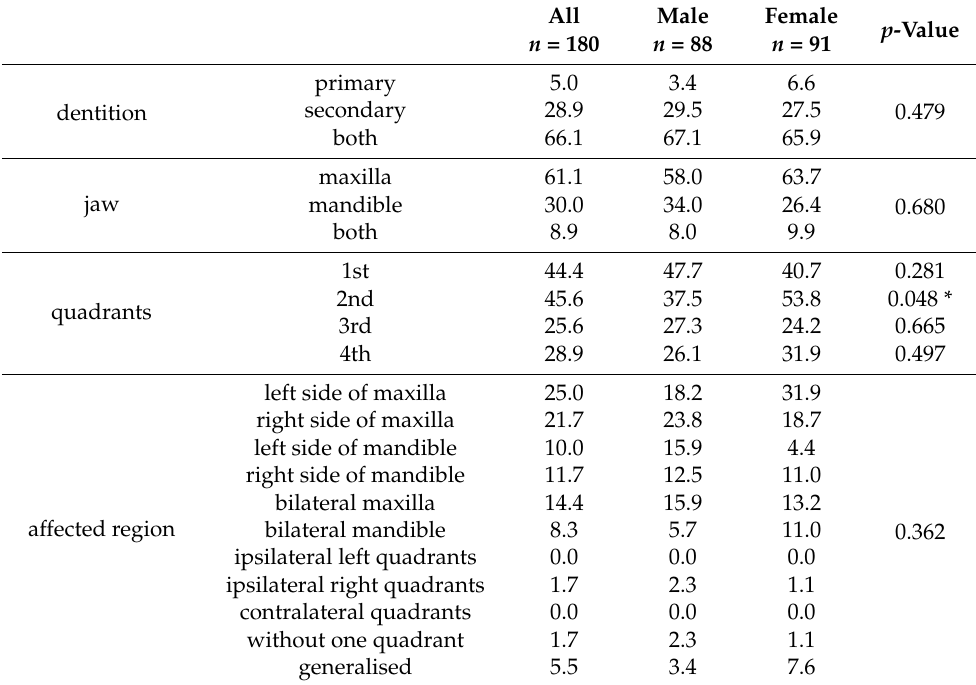
Table 2. Location of teeth affected by regional odontodysplasia (%).